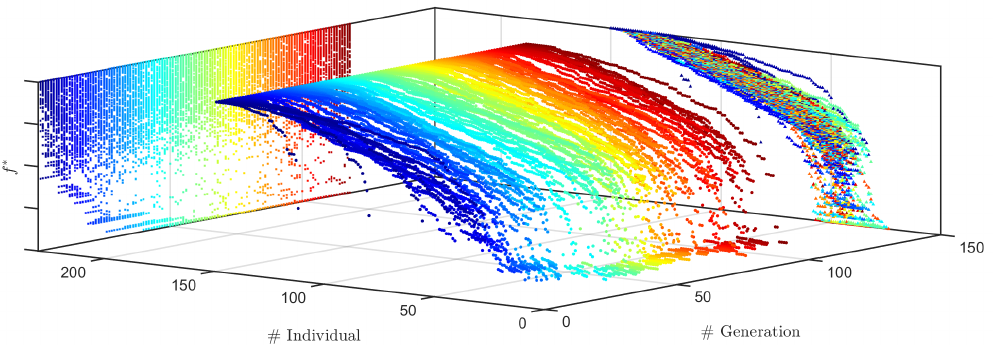
Figure 10. CoP-driven optimisation results: for each generation, individuals are sorted according to the objective function ( f ∗ ) to be minimised. The cloud of points is projected onto the vertical planes. The colour code corresponds to the generation count.